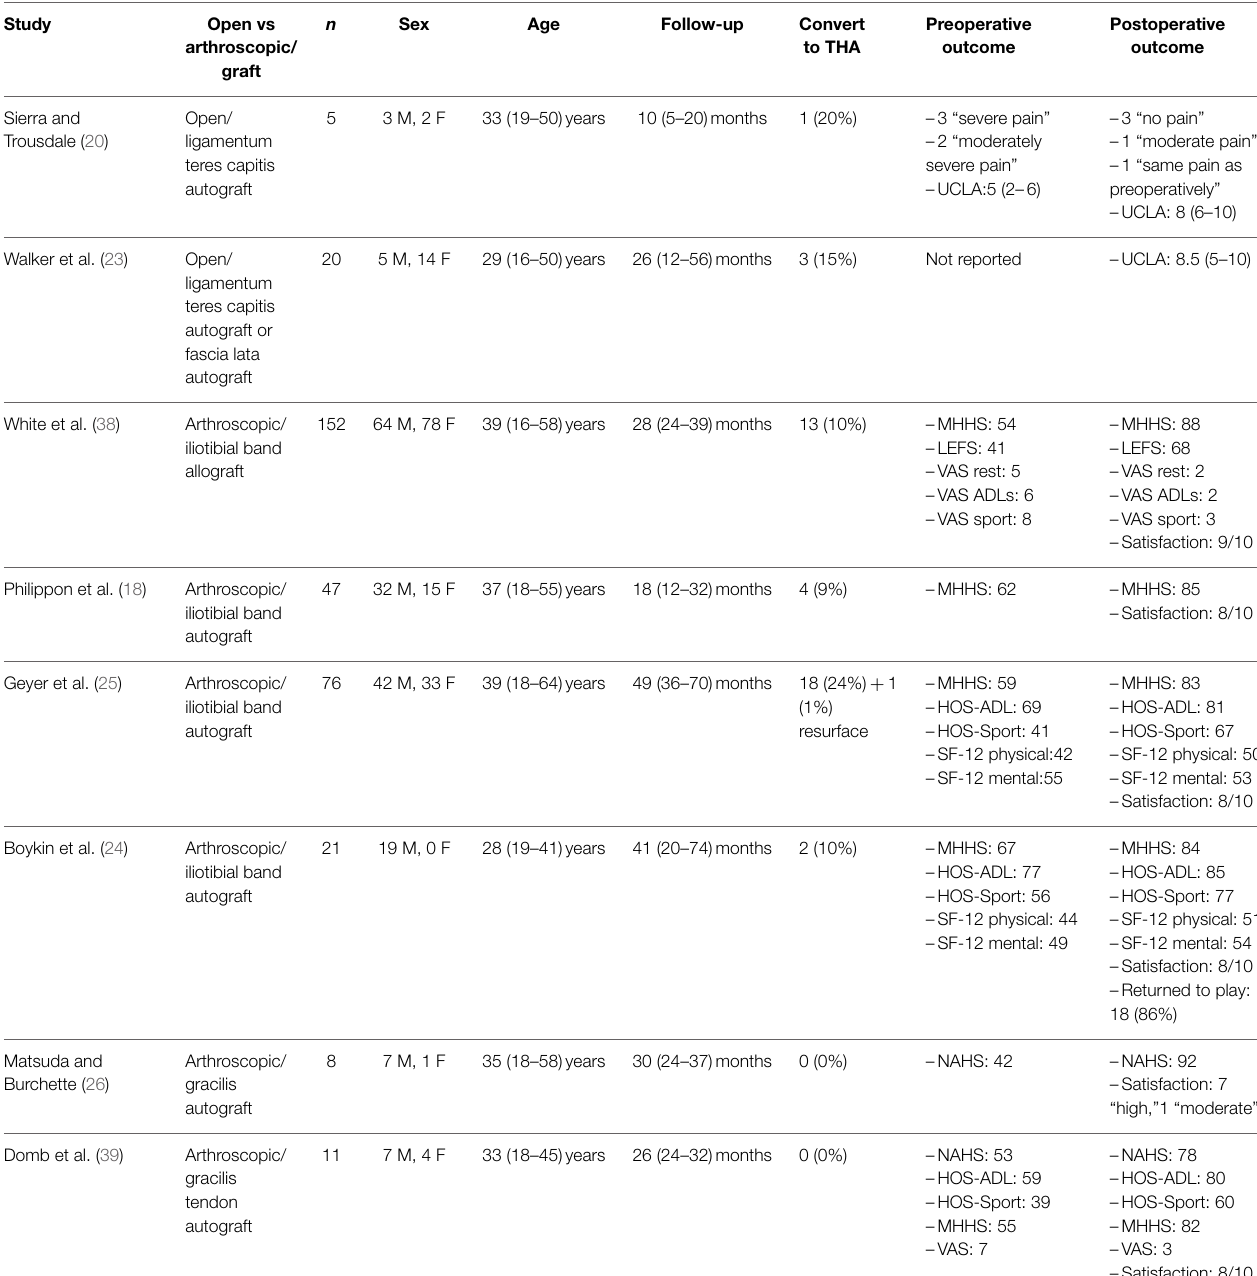
TABLE 1 | Published open and arthroscopic labral reconstruction outcomes